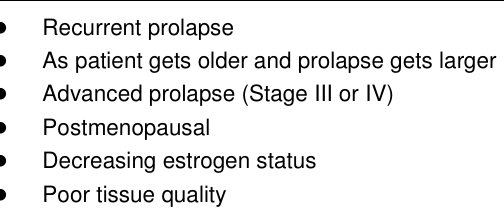
Considerations for Mesh Kit